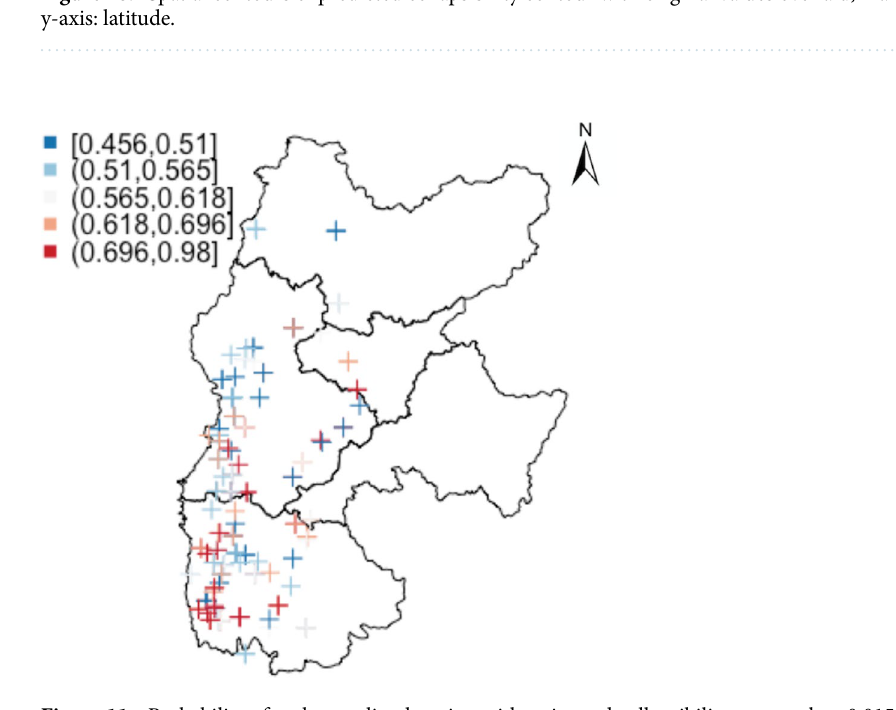
Figure 11. Probability of each sampling location with estimated collapsibility greater than